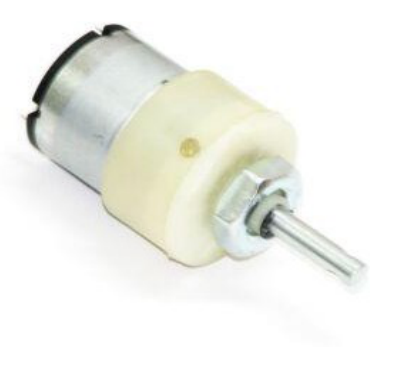
Figure 4. 12v 100 rpm DC Geared Motor